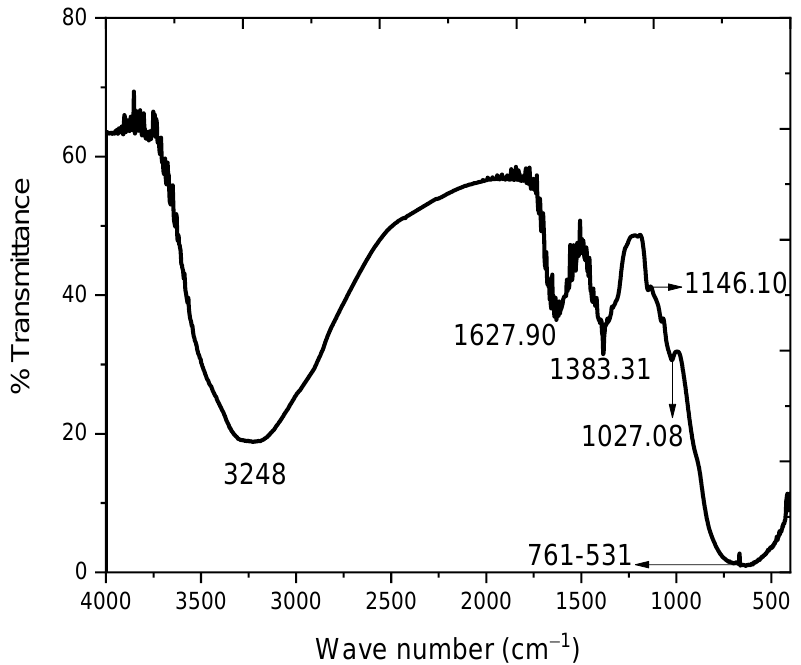
Figure 7. FTIR spectrum of SnO 2 NPs.